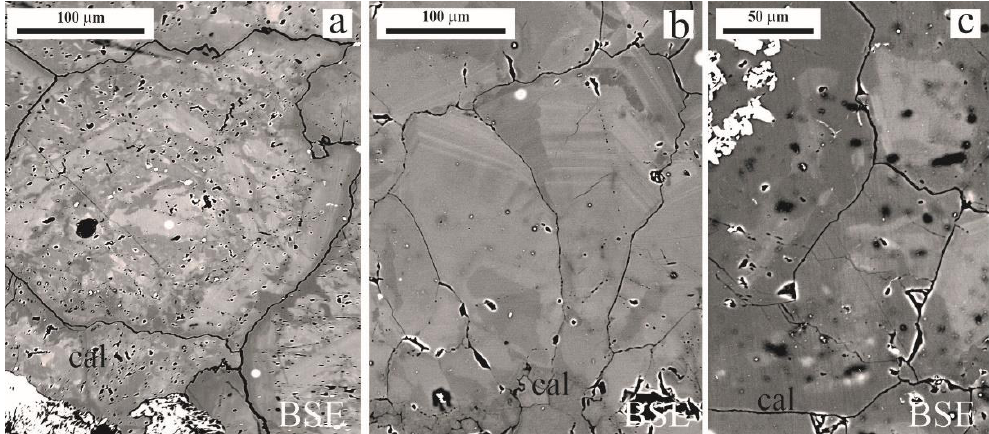
Figure 10. Back-scattered electron (BSE) images of zoned calcite aggregates crystals from: ( a , b ) Ag- Ba veins and ( c ) stratabound Mn deposits (La Serena, central Chile).